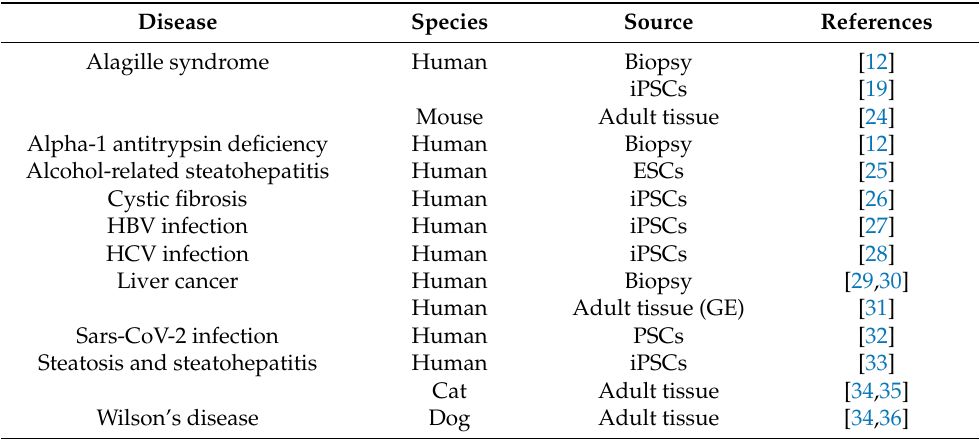
Table 1. Liver organoids application as disease